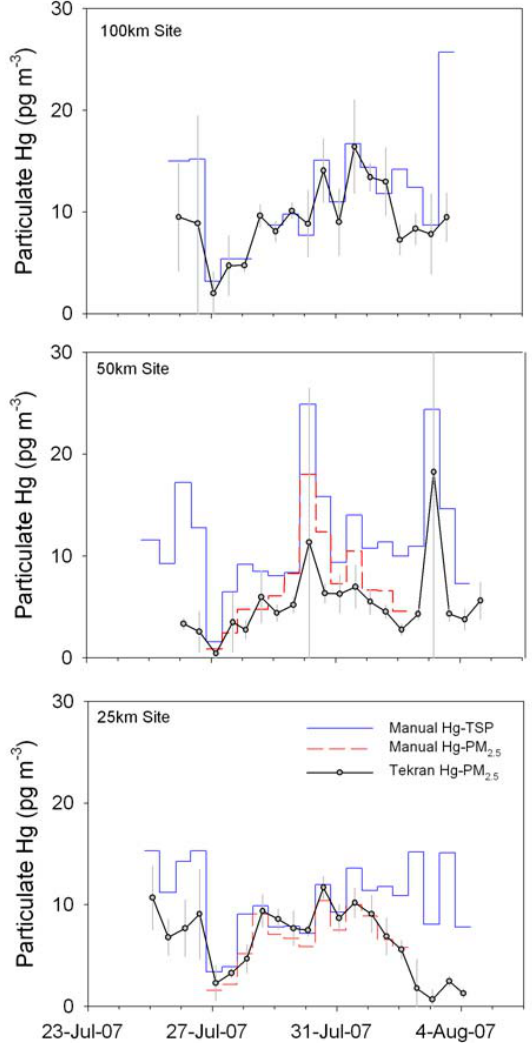
Fig. 4. Comparison of 12-h manual Hg-TSP vs. summed 12-h spe- Figure 4. Comparison of 12-h manual Hg-TSP vs. summed 12-h speciation system Hg- PM 2.5 4 ciation system Hg-PM 2 . 5 (25, 50, 100km sites) and 12-h manual (25, 50, 100 km sites) and 12-hour manual Hg-TSP (25, 50 km sites only), for the period of 5 Hg-TSP (25, 50km sites only), for the period of intensive Hg-PM 2 . 5 intensive Hg- PM 2.5 sampling, 25 July-5 August, 2007. 6 sampling, 25 July–5 August, 2007.